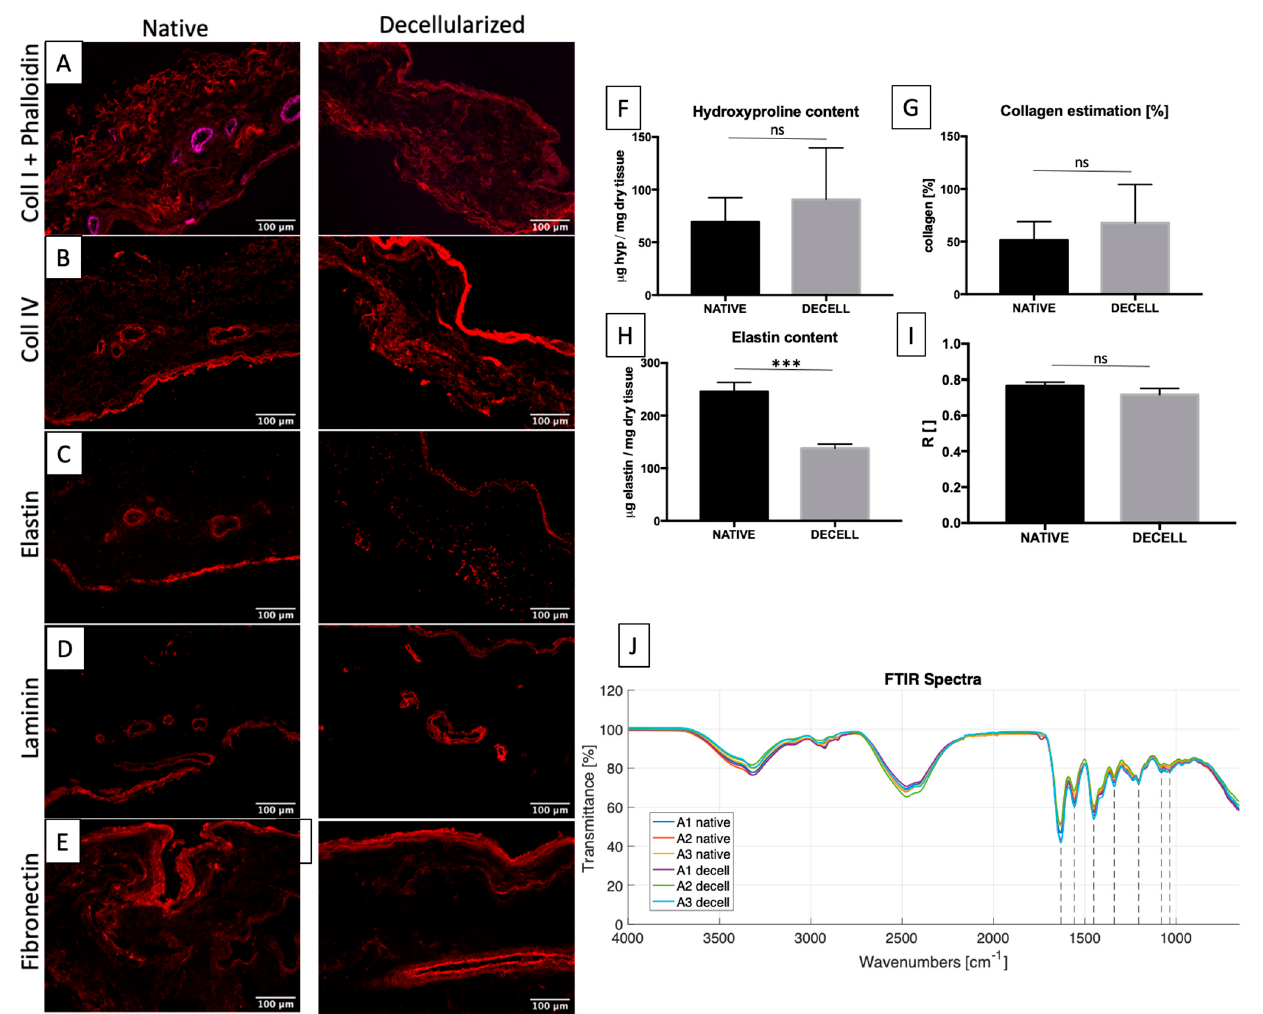
Figure 3. ( A – E ): Immunofluorescence of cellular and ECM components: collagen I (red) merged with phalloidin (magenta) ( A ), collagen IV ( B ), elastin ( C ), laminin ( D ) and fibronectin ( E ). Hydroxyproline ( F ) and elastin ( H ) quantifications are reported. No significant difference was found after hydroxyproline quantification, whereas a significant difference was found in the elastin content. Collagen estimation is reported as percentage ( G ), showing no statistical difference by t -test. *** p < 0.001 and ns p ≥ 0.05. The comparison between native and decellularized SIS of the ratio (R) between the peaks related to amide I and II is reported. (No significant difference was found using a t -test, p ≥ 0.05) ( I ). FTIR spectra are reported, showing the transmittance (%) over the wavenumbers (cm − 1 ). Dashed lines highlight peaks at 1631 cm − 1 (amide I and triple helix), 1558 cm − 1 (amide II), 1451 cm − 1 (all types of collagen), 1339 cm − 1 (collagen I and IV), 1205 cm − 1 (collagen IV and V), 1080 cm − 1 (collagen V and VI), and 1035 cm − 1 (all types of collagen) cm − 1 ( J